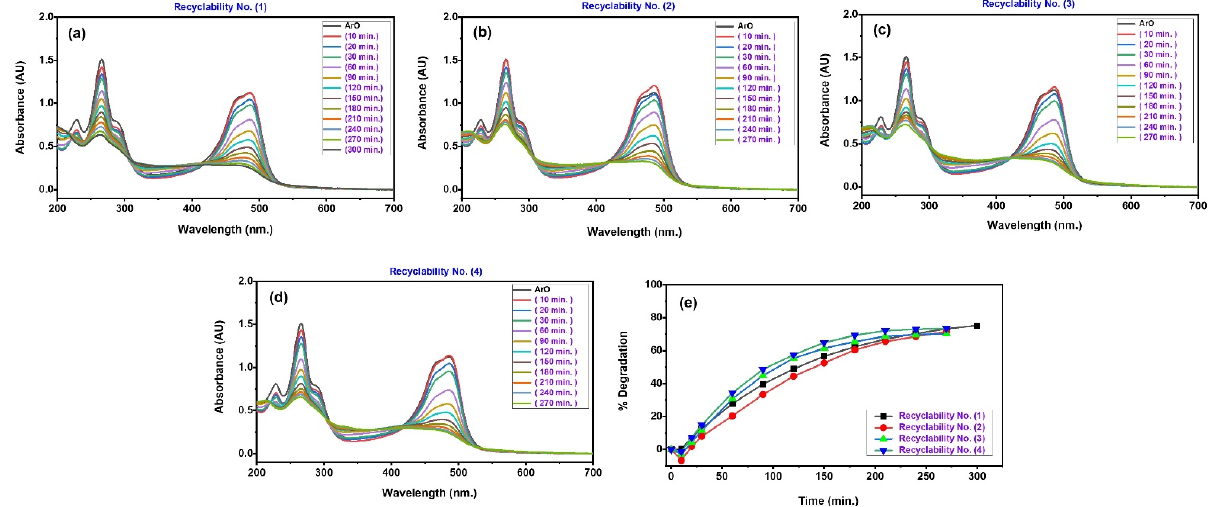
Figure 11. UV–vis absorption spectra for the photodegradation of ArO (0.07 mM) under solar light using Cu@Alg/Co–CeO 2 catalyst (4 beads): ( a ) 1st cycle, ( b ) 2nd cycle, ( c ) 3rd cycle, and ( d ) 4th cycle. ( e ) % Degradation of ArO as a function of